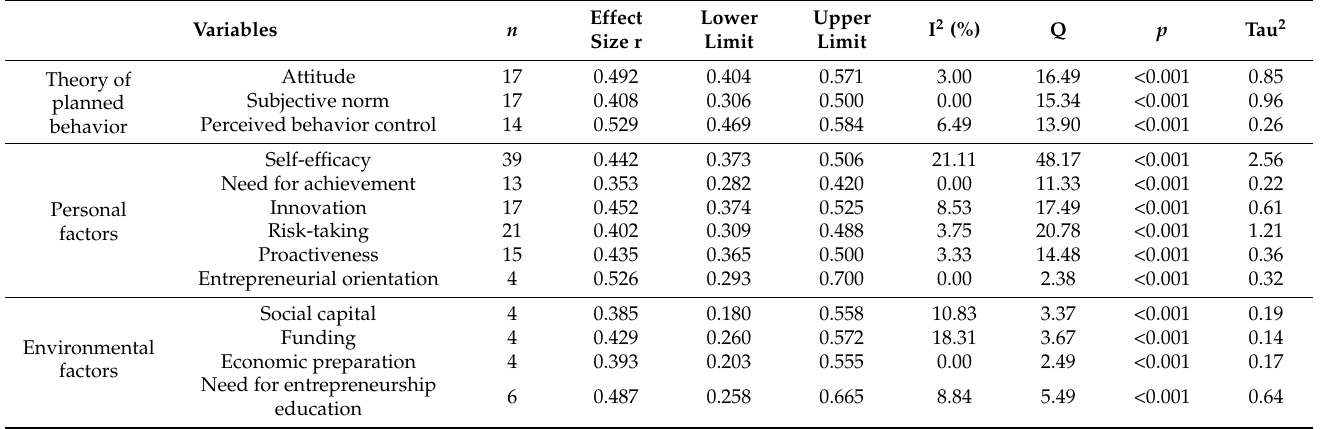
Table 1. Summary of meta correlation analysis.